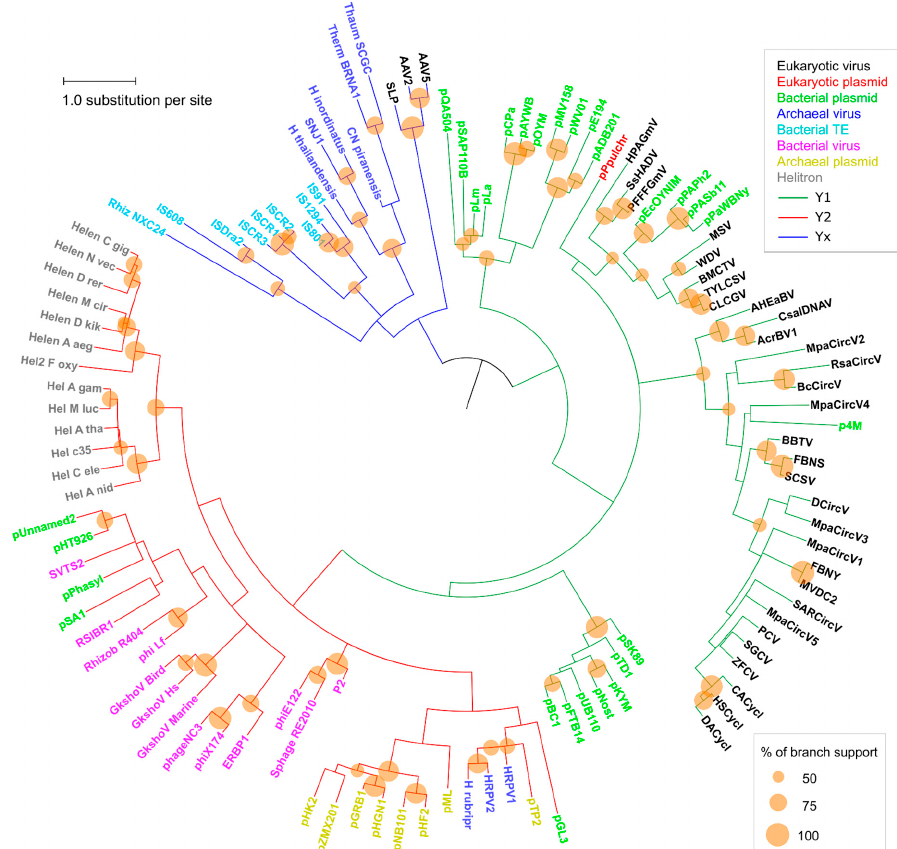
Figure 2. Phylogenetic analysis of RCRE domain sequences. Clade colors indicate each tyrosine group: Y1 (green), Y2 (red), and Yx (blue). Taxa colors represent the family of each element (box on the upper right). See Table S1 for taxa information. Phylogeny inferred by the Maximum Likelihood method (LG+G+I). The same phylogeny, with the numerical support values represented, is shown on Figure